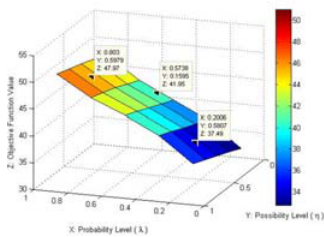
Fig. 8. Possibility optimal Fig. 9. Necessity optimal Fig. 10. Hybrid optimal solutions for any levels of ,  solutions for any levels of ,